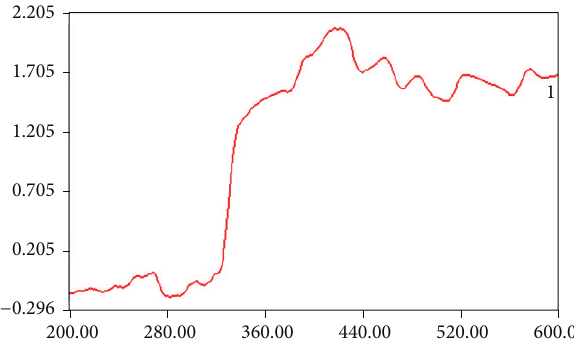
Figure 3: Zeta potential distribution of synthesized silver nanopar- ticles.